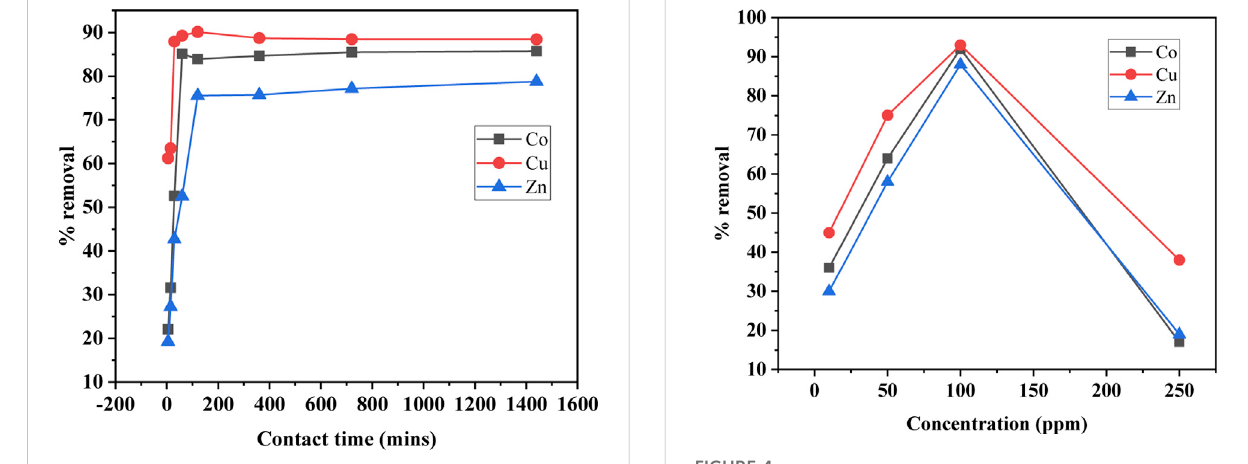
FIGURE 2 Contact time versus percentage of metal ion uptake (operating conditions: adsorbent dose 0.1 mg, pH 8, metal ions concentration 100 ppm, and temperature 25 ° C).